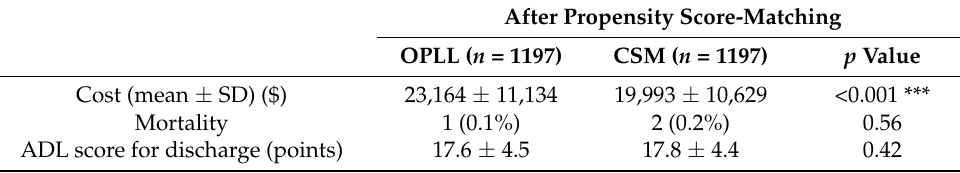
Table 4. Cost, mortality, and ADL score for discharge after